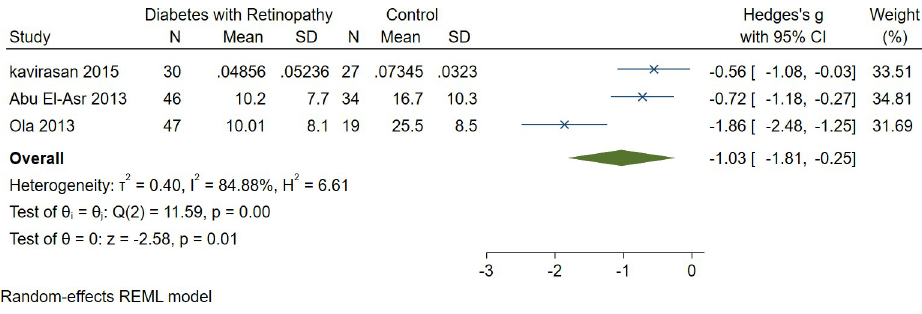
Fig 6. A meta-analysis of serum BDNF levels in patients with DM and retinopathy vs. controls.